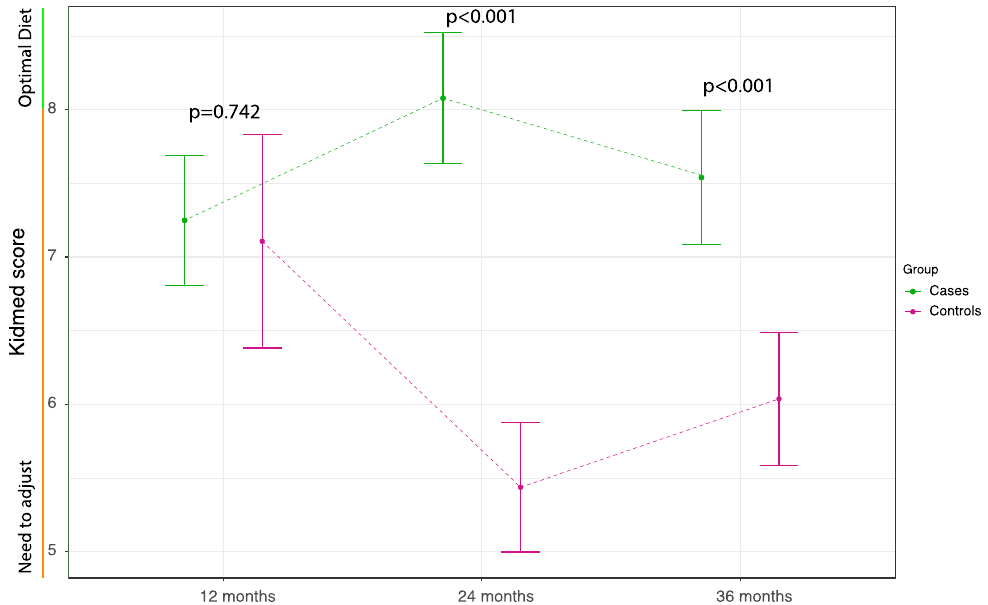
Figure 3. Longitudinal trajectories of KidMed score in children stratified by treatment arm. Results are expressed as Estimated Marginal Means (EMM) with the corresponding 95% Confidence Intervals (95% CIs). EMM’s were based on a linear mixed models using time as categorical factor.